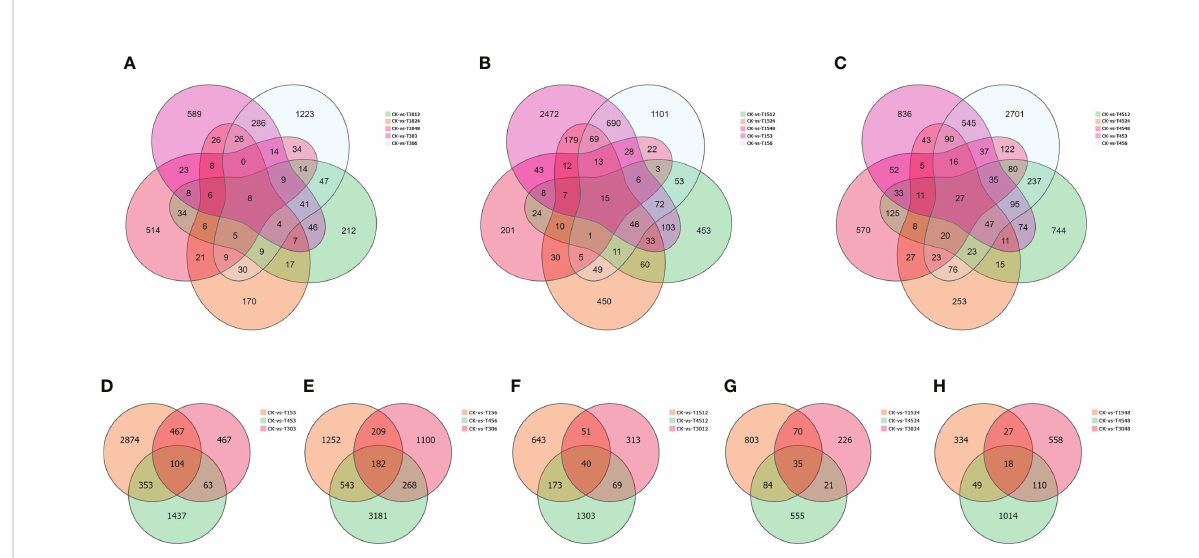
FIGURE 6 Differentially expressed genes (DEGs) under different treatments conditions. (A) Comparative analysis of DEGs under the same salinity condition (15 PSU) and different time conditions (3, 6, 12, 24, and 48 hours); (B) Comparative analysis of DEGs under the same salinity condition(30 PSU) and different time conditions (3, 6, 12, 24, 48 hours); (C) Comparative analysis of DEGs under the same salinity condition(45 PSU) and different time conditions (3, 6, 12, 24, 48 hours); (D) Comparative analysis of DEGs under different salinities after 3 hour treatment; (E) Comparative analysis of DEGs under different salinities after 6 hour treatment; (F) Comparative analysis of DEGs under different salinities after 12 hour treatment; (G) Comparative analysis of DEGs under different salinities after 24 hour treatment; (H) Comparative analysis of DEGs under different salinities after 48 hour treatment.